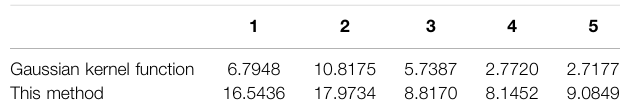
TABLE 2 | Evaluation of SD for fi ve sets of images.